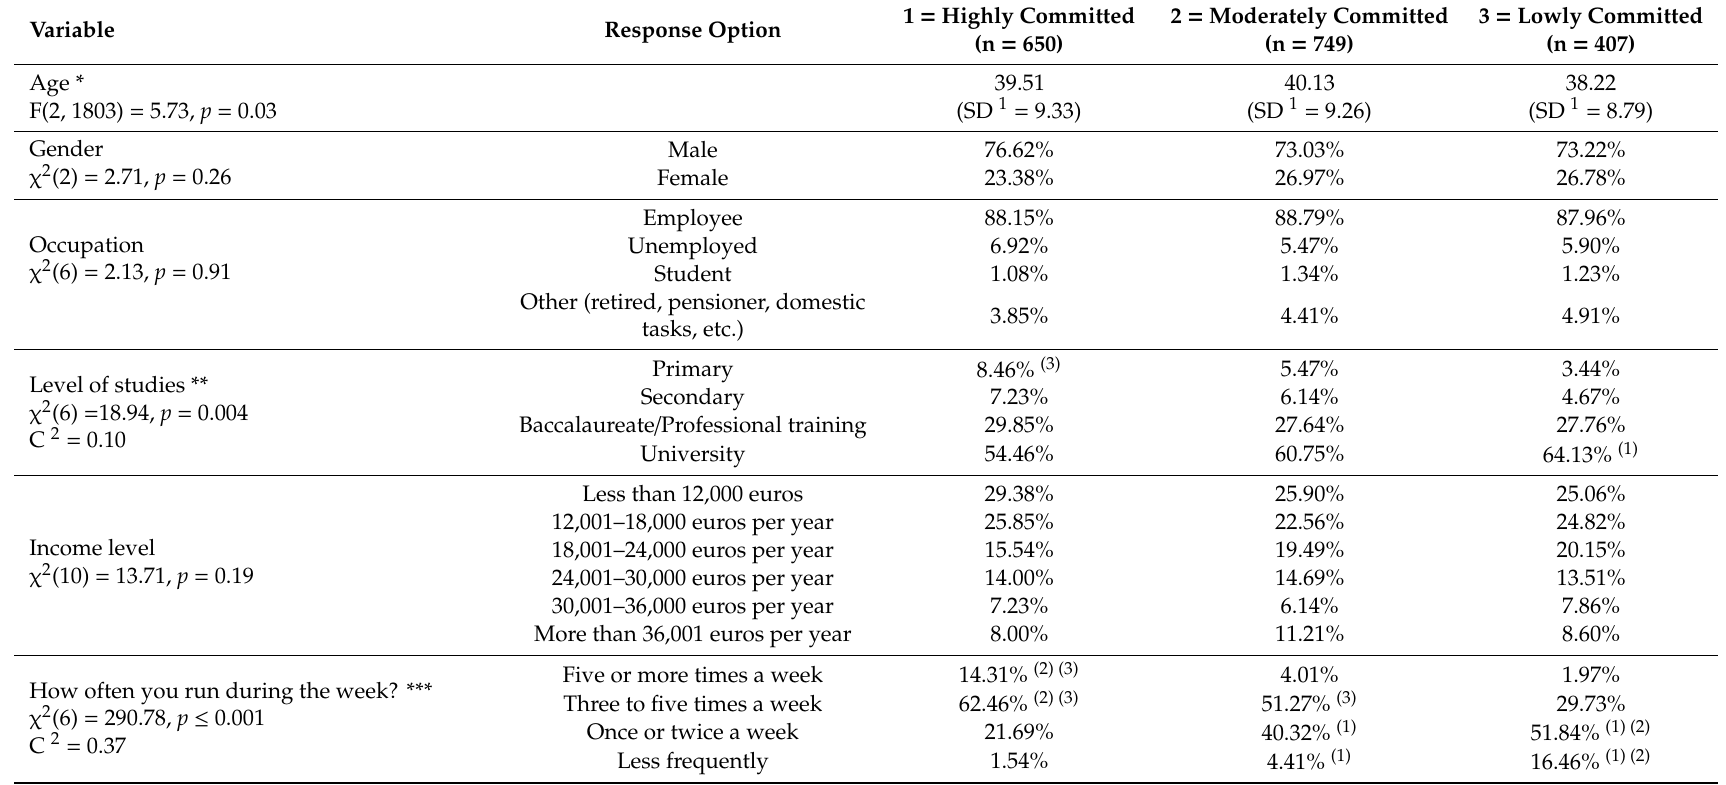
Table 6. Characteristics of the di ff erent groups